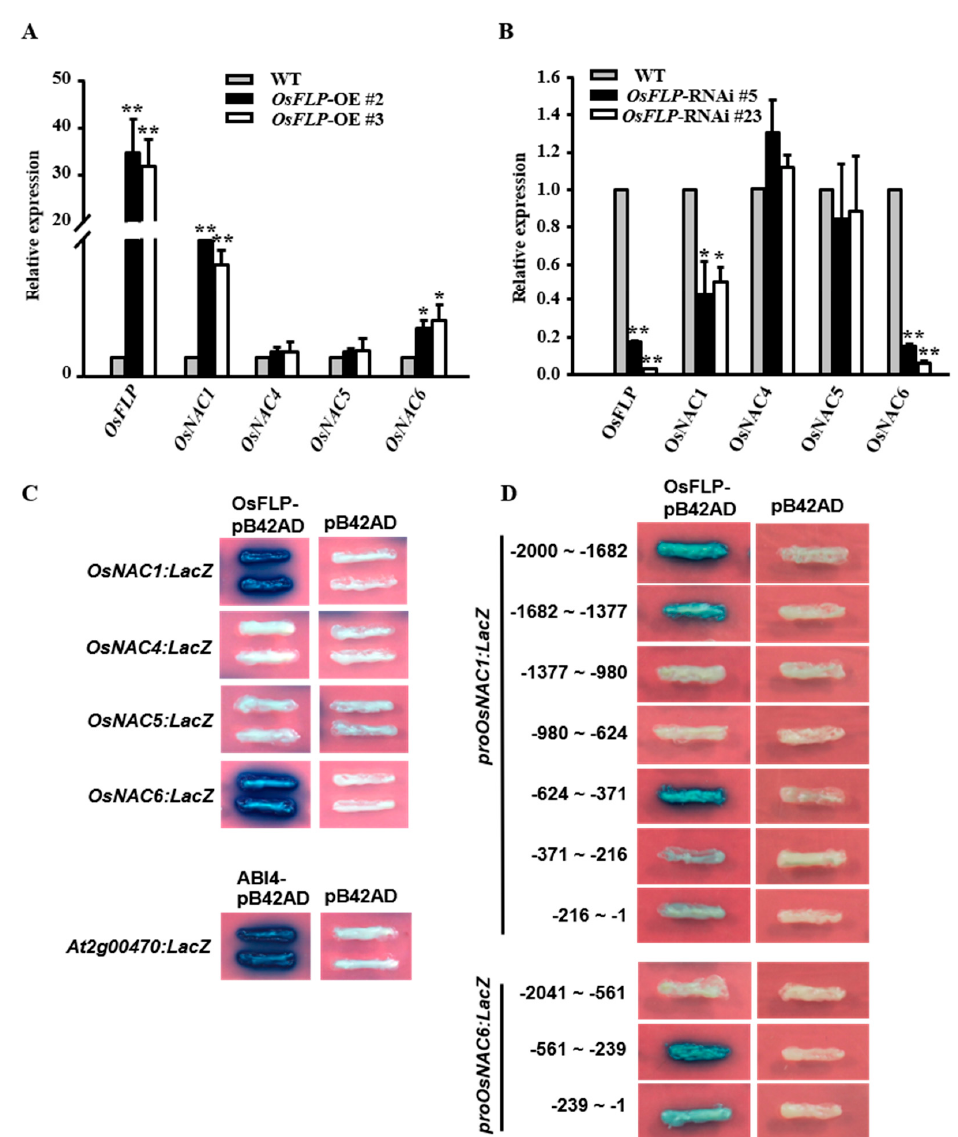
Figure 6. OsFLP positively regulates the NAC genes and specially binds to the promoters of OsNAC1 and OsNAC66 , respectively. ( A ) Expression levels of OsFLP , OsNAC1 and OsNAC6 were increased in OsFLP -overexpression lines. Error bar means ± SD. ( B ) Expression levels of OsFLP , OsNAC1 and OsNAC6 were reduced in OsFLP knockdown lines. Error bar means ± SD. ( C ) LacZ reporter genes were strongly activated and driven by OsNAC1 and OsNAC6 promoters in yeast. LacZ reporter driven by At2g00470 was used as a positive control. ( D ) The full length of the promoter region of OsNAC1 was truncated into seven fragments. Three fragments of − 645 bp to − 371 bp, − 1682 bp to − 1377 bp and − 2000 bp to − 1682 bp were identified as the binding regions of OsFLP. The full length of the promoter region of OsNAC6 was truncated into three fragments. Two fragments of − 561 bp to − 239 bp and − 239 bp to − 1 bp were identified as the binding region of OsFLP. Asterisks indicate a significant difference to wild-type (Student’s t − test, ** p < 0.01, * p <